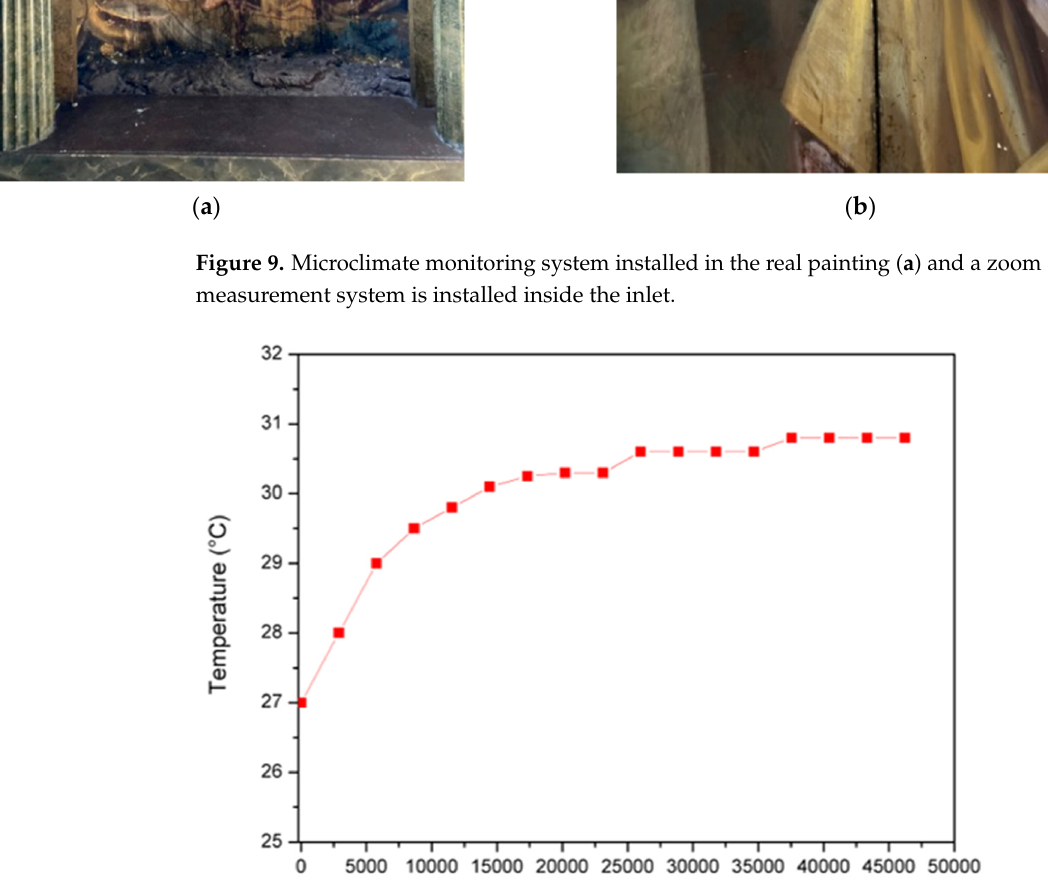
Figure 9. Microclimate monitoring system installed in the real painting ( a ) and a zoom ( b ) where the measurement system is installed inside the inlet.